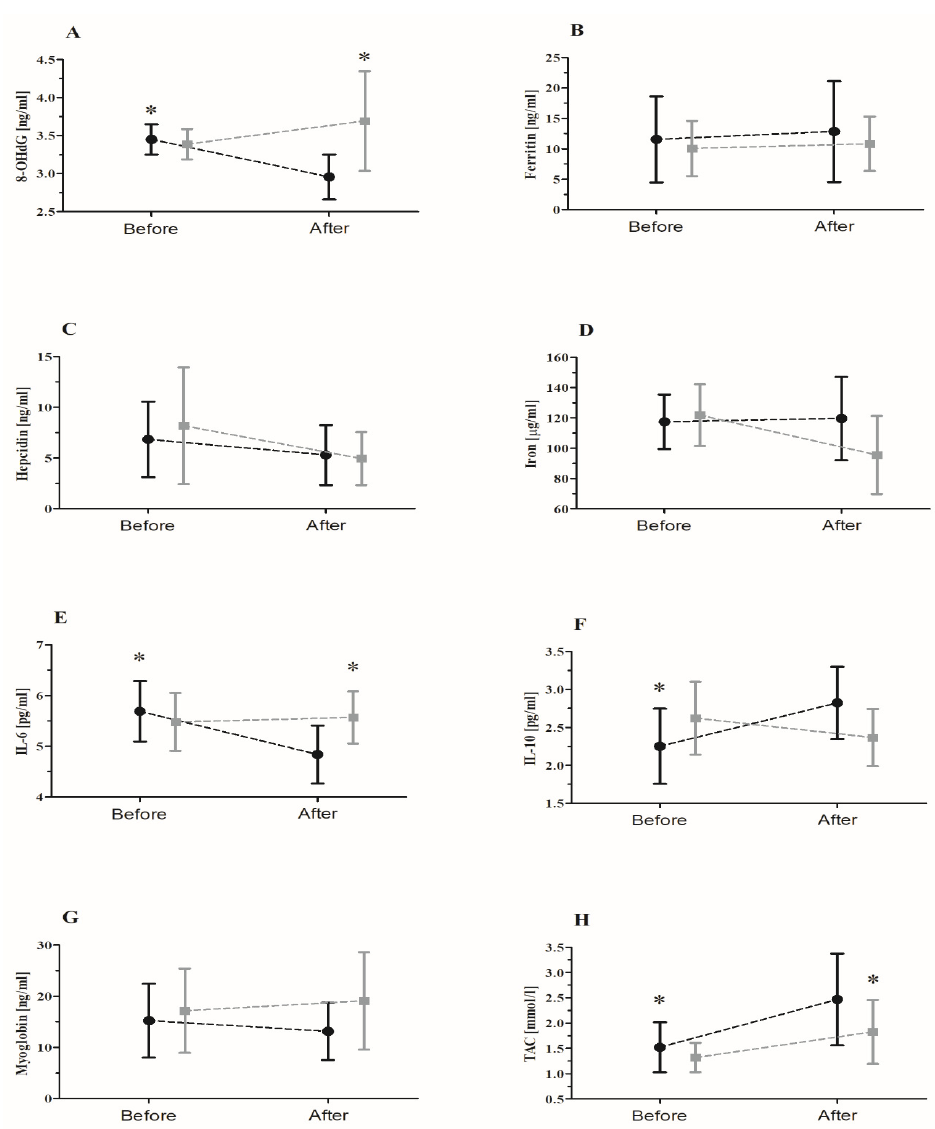
Figure 1. The mean ± SD resting levels of specific inflammatory markers before and after 90 days of supplementation with a lyophilizate of black chokeberry extract: ( A ) 8-OHdG, ( B ) ferritin, ( C ) hepcidin, ( D ) iron, ( E ) IL-6, ( F ) IL-10, ( G ) myoglobin, and ( H ) TAC. Black circles, supplemented group ( n = 12); gray squares, placebo group ( n = 10). Abbreviations: 8-OHdG, 8-hydroxydeoxyguanosine; IL-6, interleukin 6; IL-10, interleukin 10; TAC, total antioxidant capacity; * significant difference vs. supplemented group after 90 days of supplementation with a lyophilizate of black chokeberry extract.